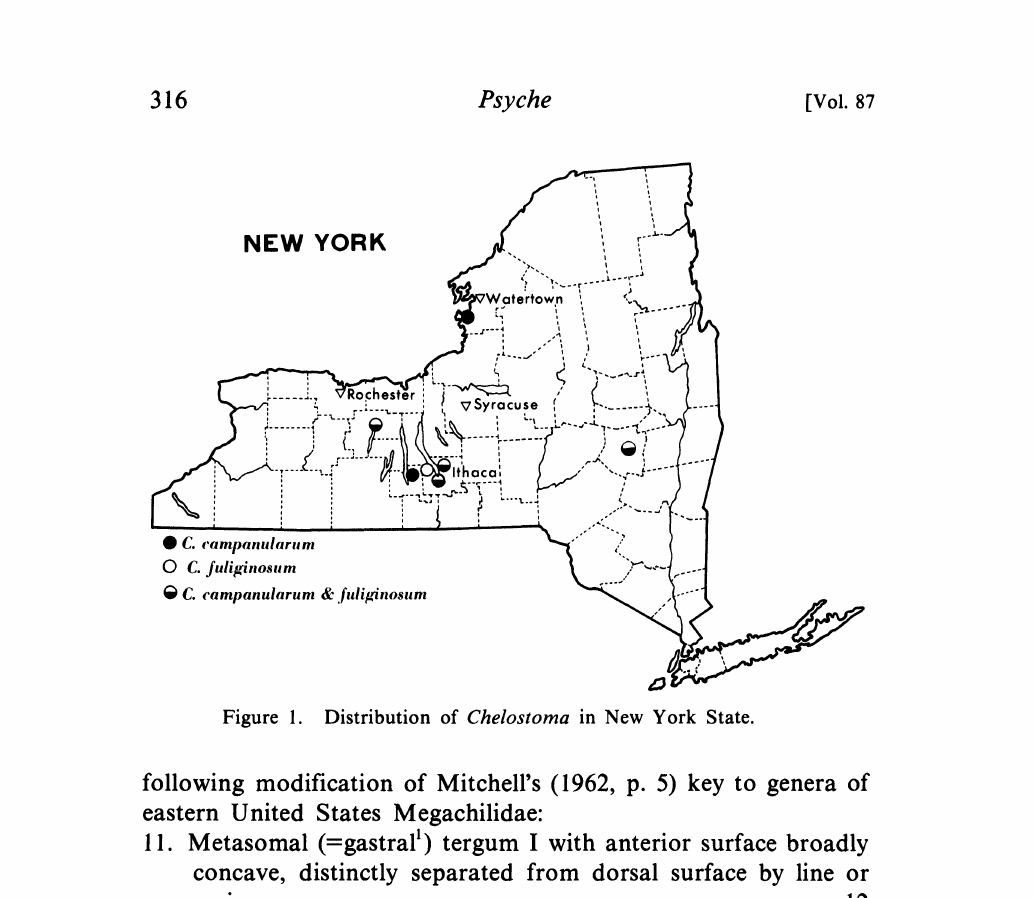
Figure 1. Distribution of Chelostoma in New York